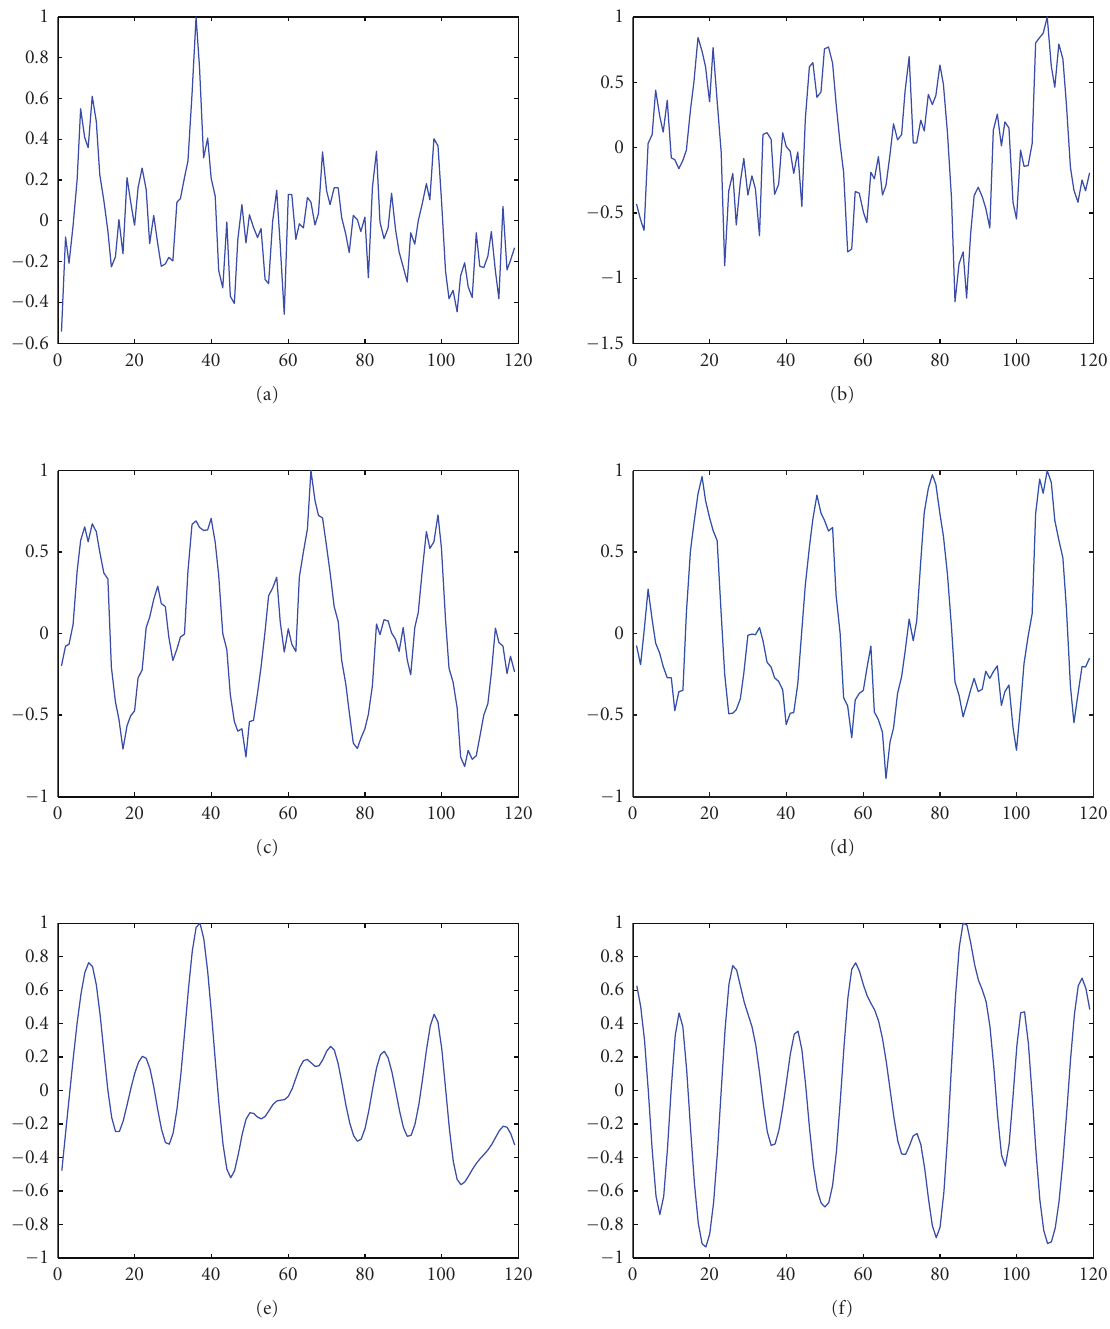
Figure 6: Results of temporal ICA: (a) right visuomotor time course estimated by extended Infomax, (b) left visuomotor time course estimated by extended Infomax, (c) right visuomotor time course estimated by FS-Infomax, (d) left visuomotor time course estimated by FS-Infomax, (e) right visuomotor time course estimated by extended Infomax with post feature-selective filtering, (f) left visuomotor time is the calculated correlation with the corresponding task course estimated by extended Infomax with post feature-selective filtering; r tt 0 = 0 . 69 ± 0 . 01, (b) r = 0 . 66 ± 0 . 01, (c) r = 0 . 79 ± 0 . 01, (d) r = 0 . 87 ± 0 . 01, (e) r = 0 . 76 ± 0 . 01, (f) r = 0 . 70 ± 0 . paradigm: (a) r tt tt 0 tt 0 tt 0 tt 0 tt 0 0